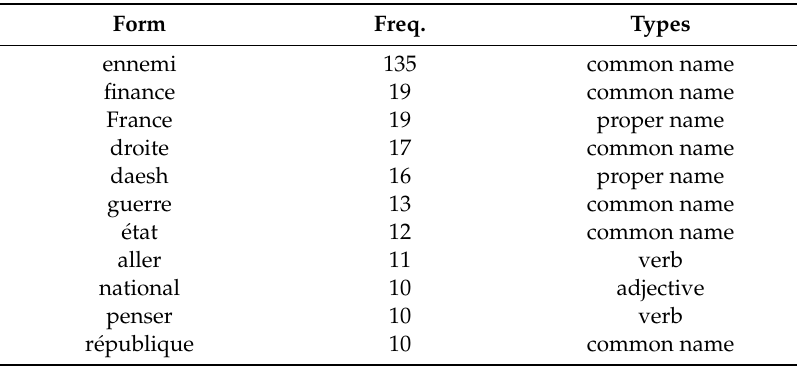
Table 1. Lemmas of the subcorpus. 3 .